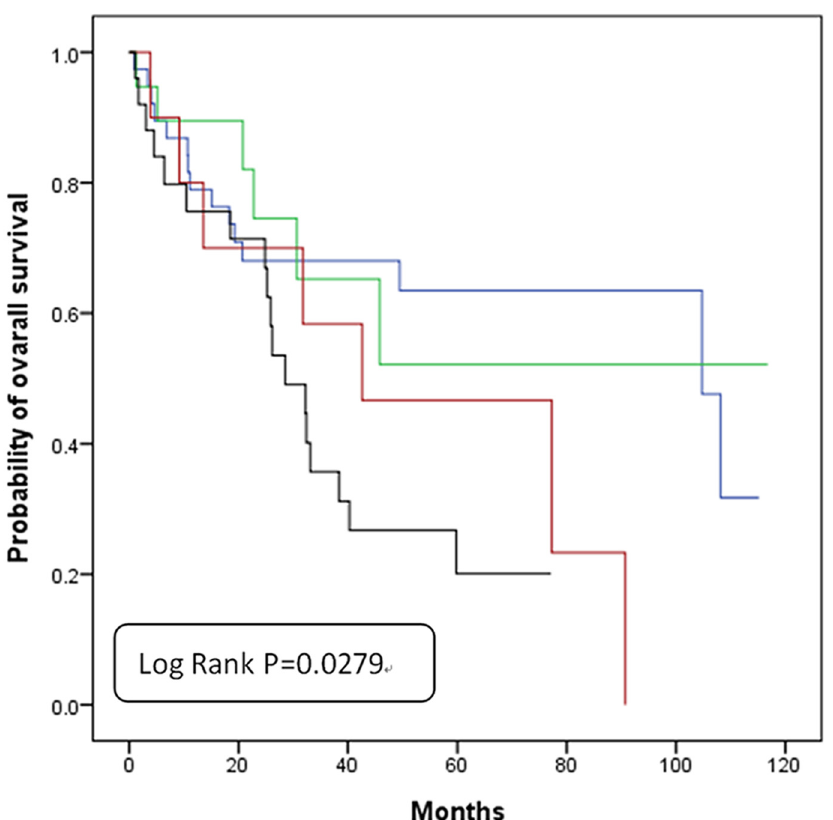
Fig 2. Overall survival of lung adenocarcinoma patients based on expression or lack of expression of FEN1 and RAD54B expressions. Blue line: FEN1(-) and RAD54B(-); Green line: FEN1(+) and RAD54B(-); Red line: FEN1(-) and RAD54B(+); Black line: FEN1(+)and RAD54B(+).